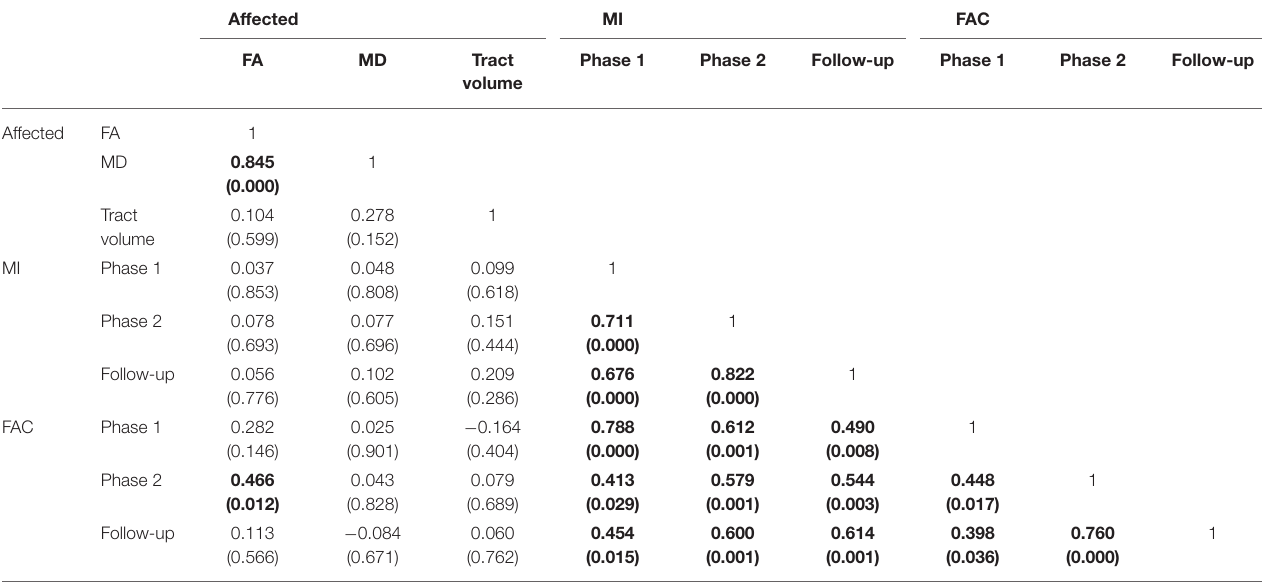
DTI, diffusion tensor imaging; PIVC, parieto-insular vestibular cortex; Affected, affected hemisphere; MI, motricity index; FAC, functional ambulatory category; Phase 1, start of rehabilitation; Phase 2, end of rehabilitation; Follow-up, follow-up 6 months after onset; FA, fractional anisotropy; MD, mean diffusivity. Values represent Spearman correlation coefficient (p value). Correlations significant at p < 0.05 are in bold (uncorrected).